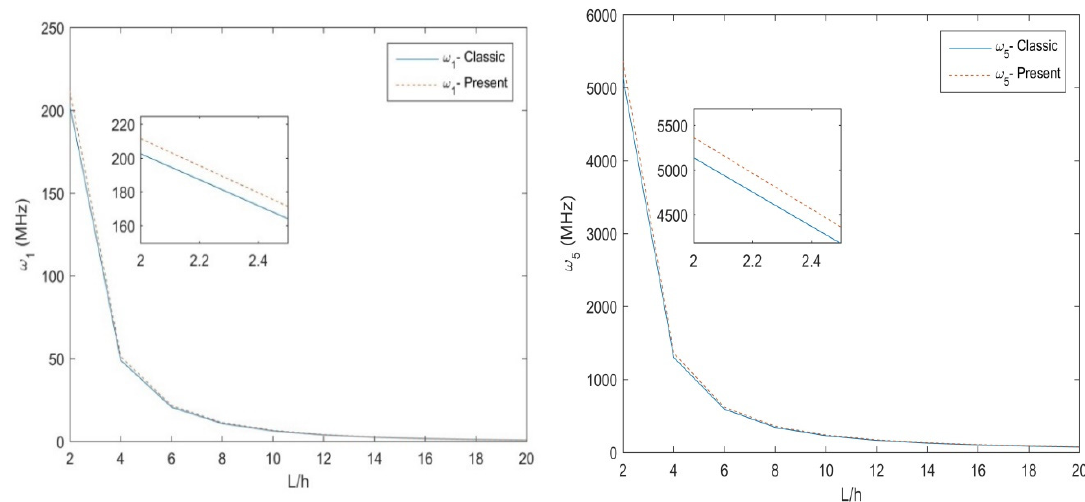
Figure 2. The 1 st and 5 th natural frequency for the S-S three-layer [90°,0°,90°] Euler–Bernoulli non-uniform beam.